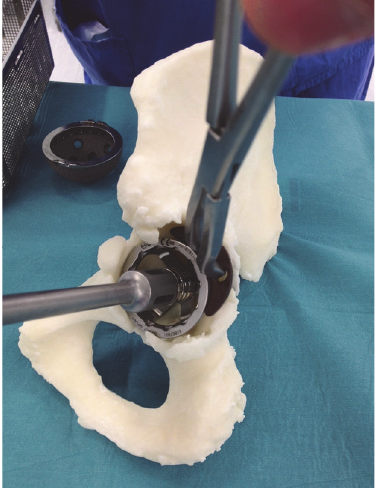
Figure 14: Preoperative templating, implant sizing, and surgi- cal stimulation (note: these figures in print journal are two- dimensional, thus limiting the true demonstration of the value of 3D printed models in providing an accurate understanding and repre- sentation of the complex deformities and corrective reconstructive techniques).